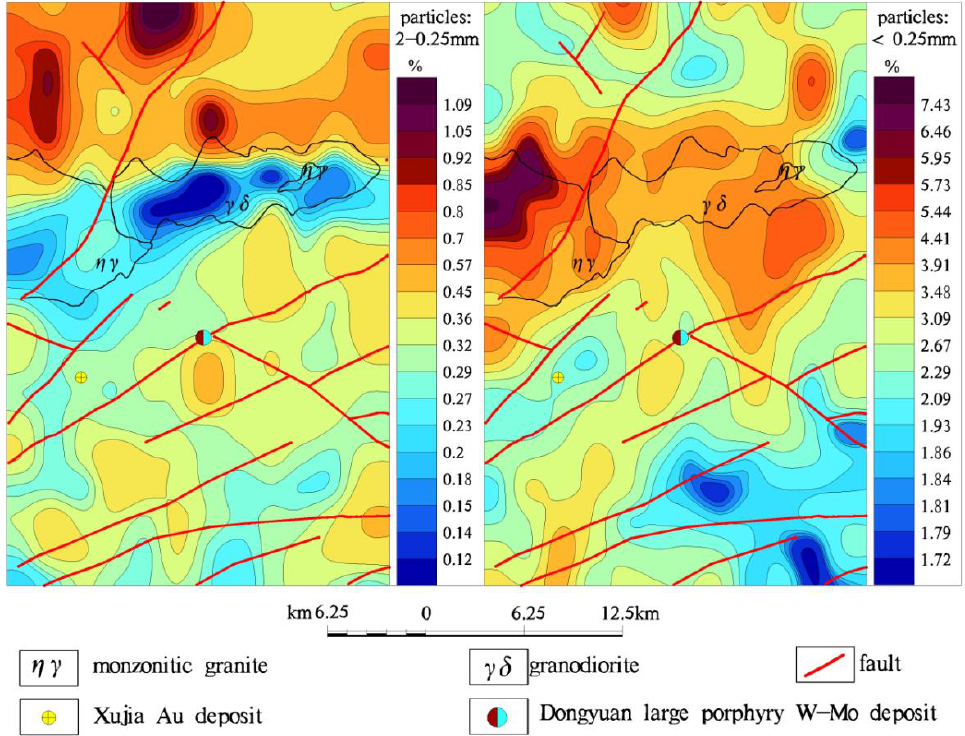
Figure 6. Geochemical maps of organic carbon in 0.25 – 2 mm and <0.25 mm fraction of stream sedi- ments in the pilot area. sediments in the pilot